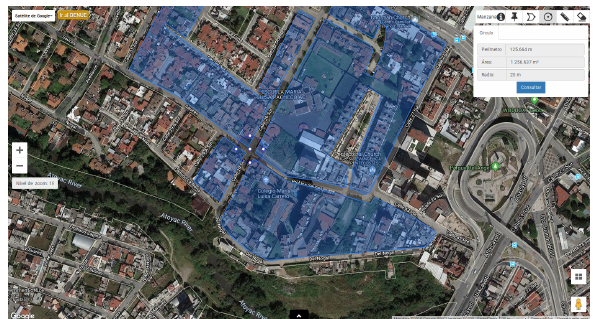
Figure 4. Interactive map from INV website.